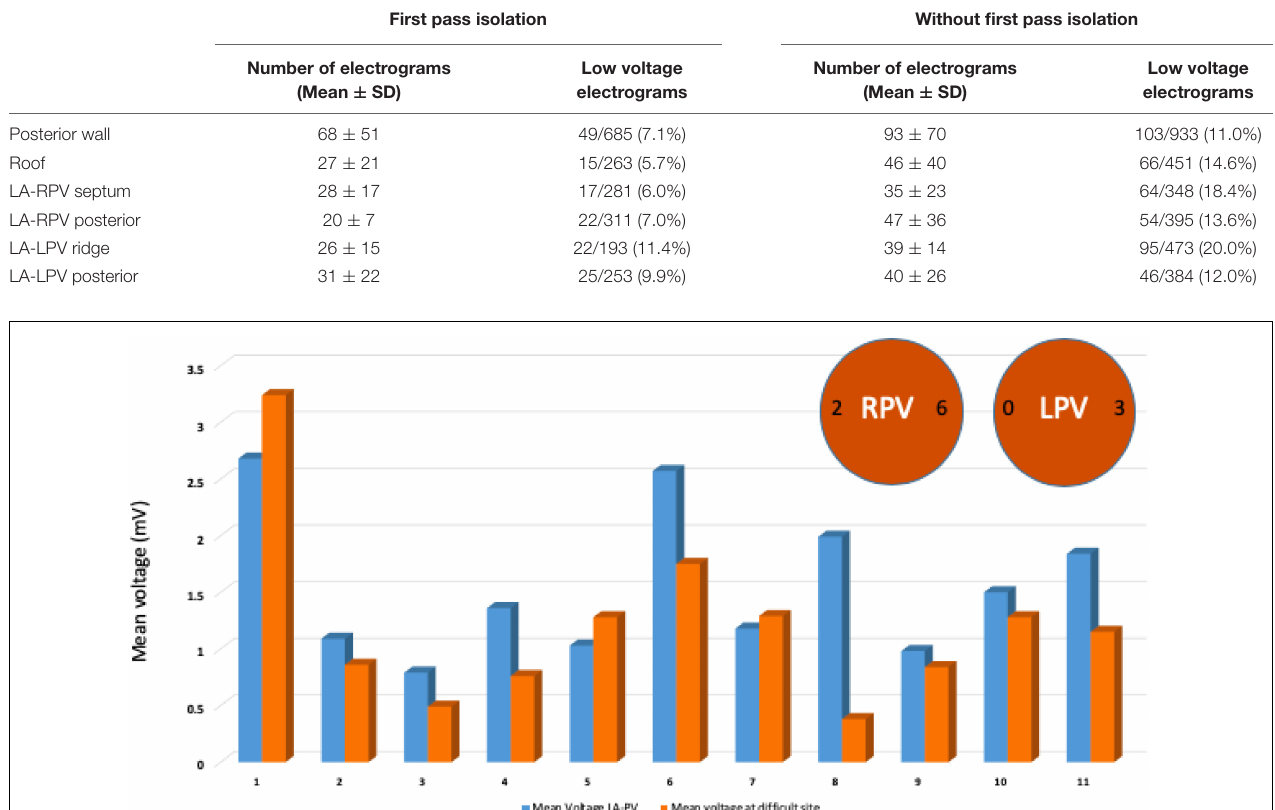
FIGURE 3 | Mean voltage at the site of failure of first pass isolation compared to mean voltage at the remaining sites from same LA-PV junction region. Descriptive analysis and comparison performed and illustrated by bar graphs of mean voltage showing lower baseline voltage at 8 of 11 sites of persistent PV connections. Typical location of persistent PV connection at posterior or anterior carina after first pass isolation highlighted by